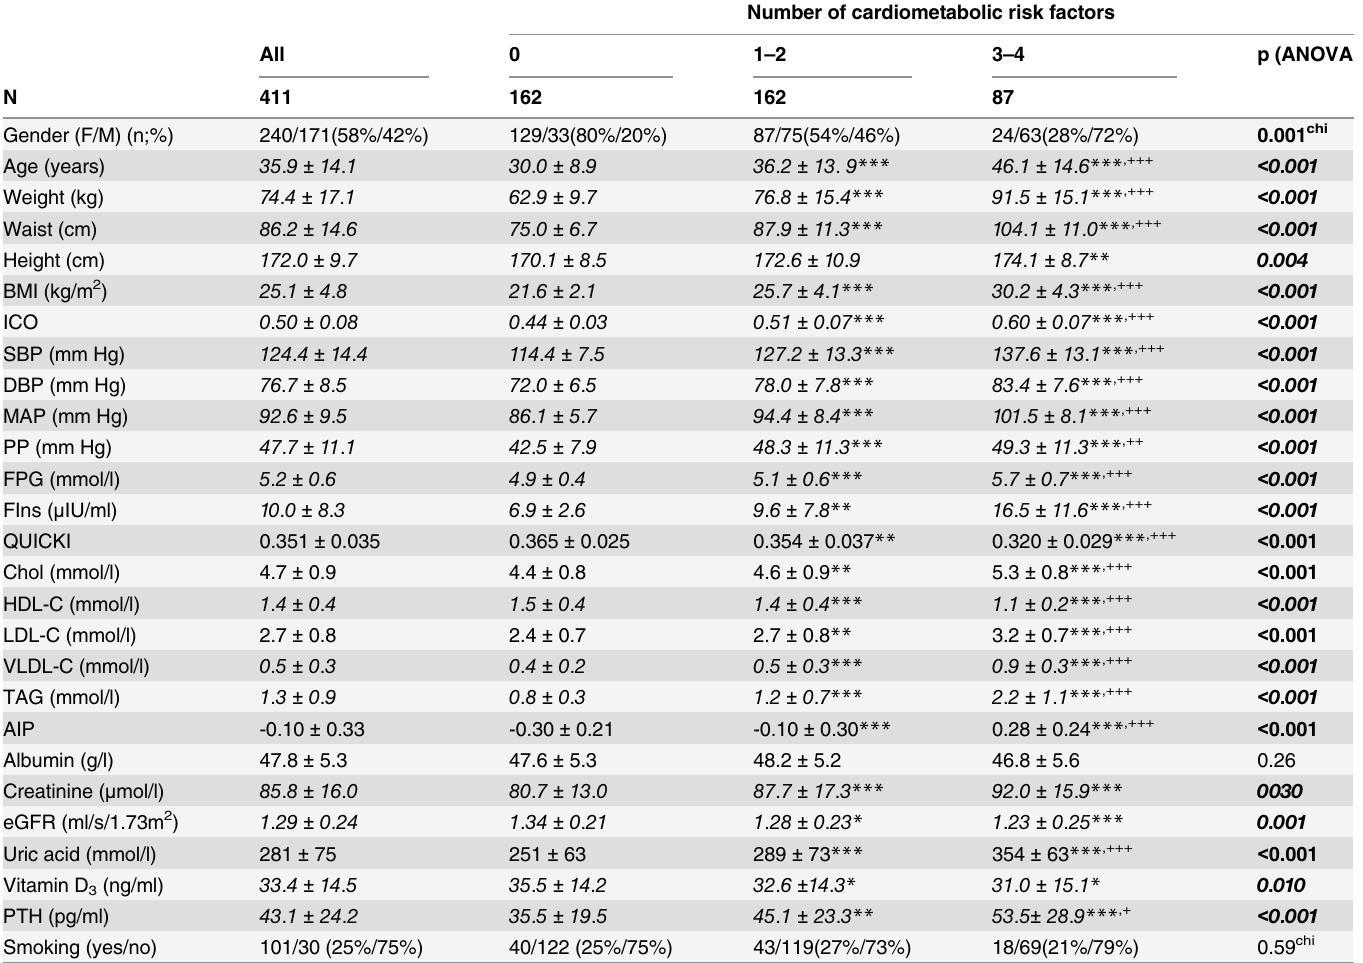
Table 1. Cohort characteristics: anthropometric data, blood pressure, standard blood chemistry variables and 25(OH)D 3 levels. Number of cardiometabolic risk